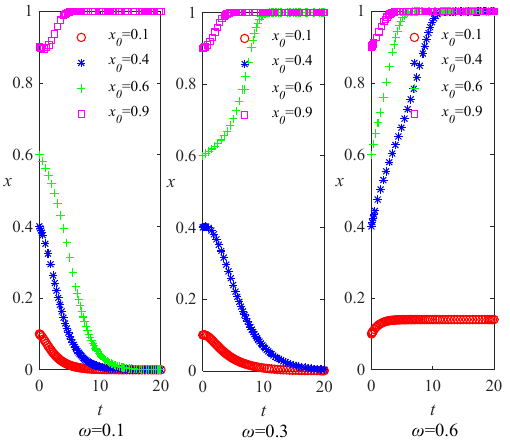
Figure 14. The impact of public participation on system evolution results.